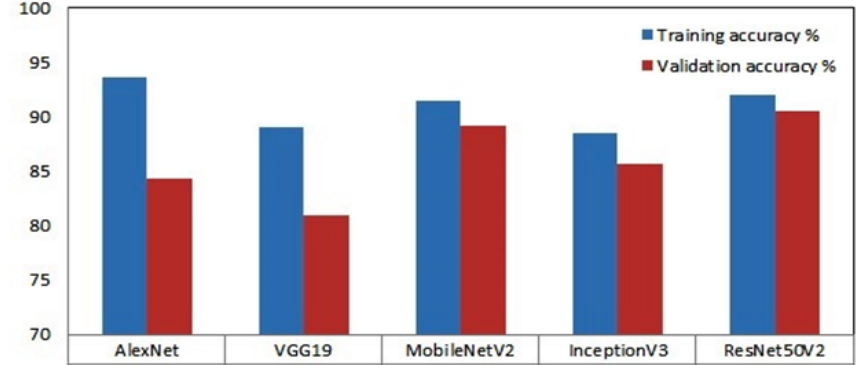
Figure 7. Training and validation accuracy in face mask detection .